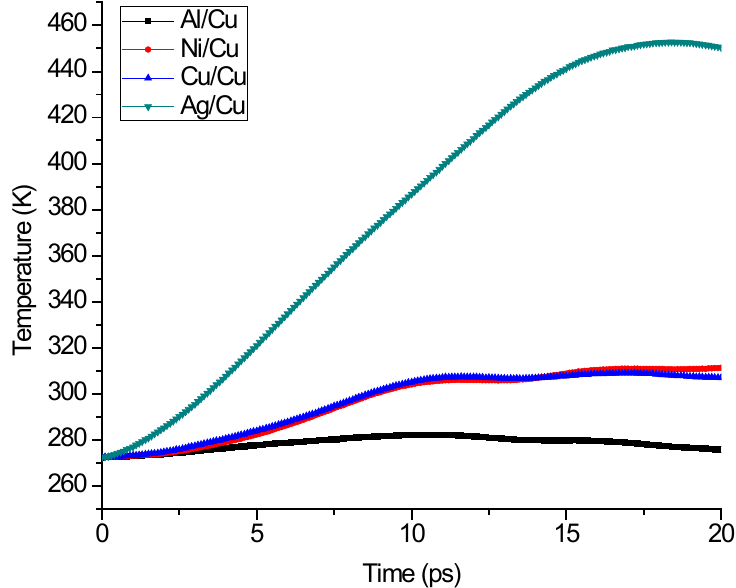
Figure 5. The temporal temperature evolution at the periphery of the particle/substrate interfacial region at 1000 m/s of single-particle impact.